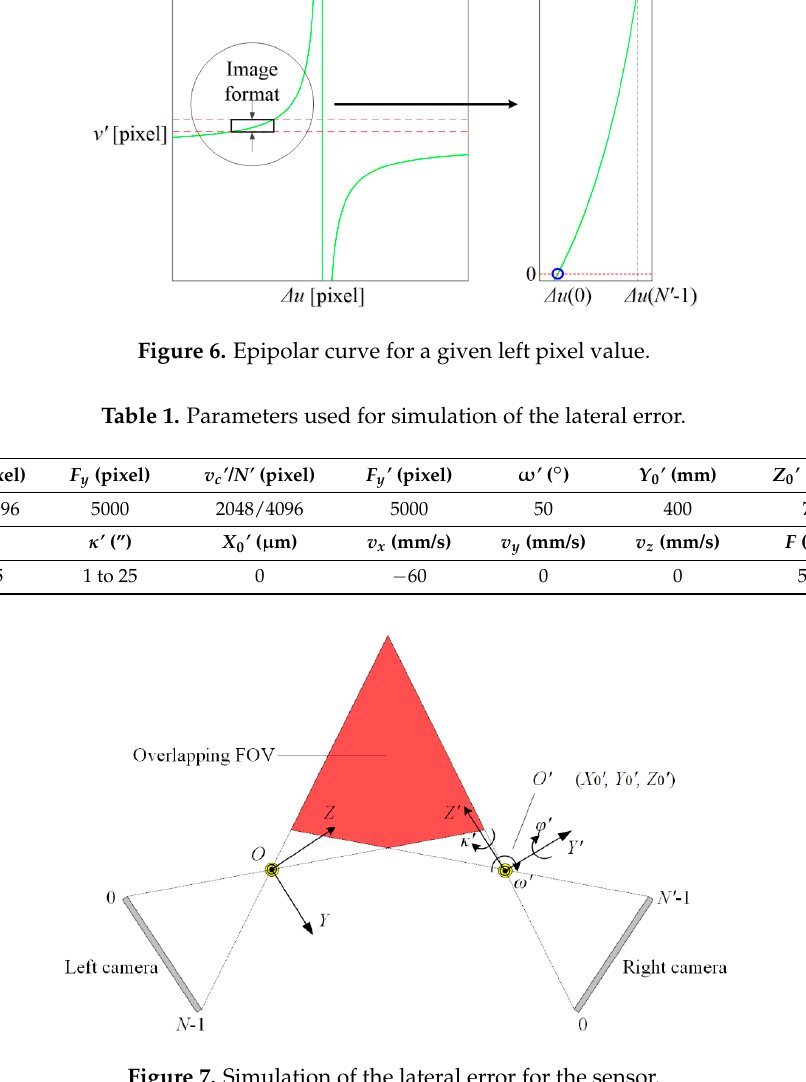
Figure 7. Simulation of the lateral error for the sensor.